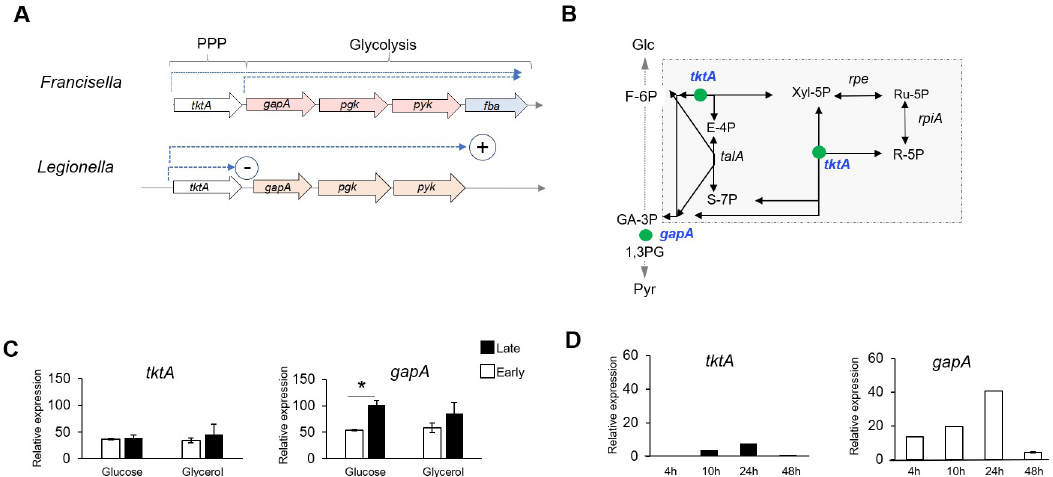
Fig 1. Transcriptional analysis of tktA and gapA genes. (A) Schematic organization of the tktA operon in F . novicida and Legionella pneumophila . The terms PPP and Glycolysis on top, indicate the genes involved in either the PPP or the Glycolytic/ gluconeogenic pathways. The last gene of the Francisella locus is absent in the Legionella locus ( fba ). The dotted blue arrows indicate the predicted transcriptional units. In Legionella , in the absence of the CsrA regulatory protein, transcription is interrupted after tktA (circled sign -) whereas in the presence of CsrA, transcription resumes till the end of the operon (circled sign +). ( B ) The enzymatic reactions corresponding to TktA and GapA enzymes are shown as green balls on a schematic depiction of the PPP and glycolytic pathways. (C) qRT-PCR analysis of tktA and gapA genes in WT F . novicida , grown in CDM supplemented either with glucose or glycerol, in exponential (Early, white labels) and stationary phase of growth (Late, black labels). (D) qRT-PCR analysis of tktA and gapA genes in WT F . novicida , over a 24 hour-period of intracellular growth in J774-1 macrophages. � , P < 0.01 (as determined by Student’s t test).